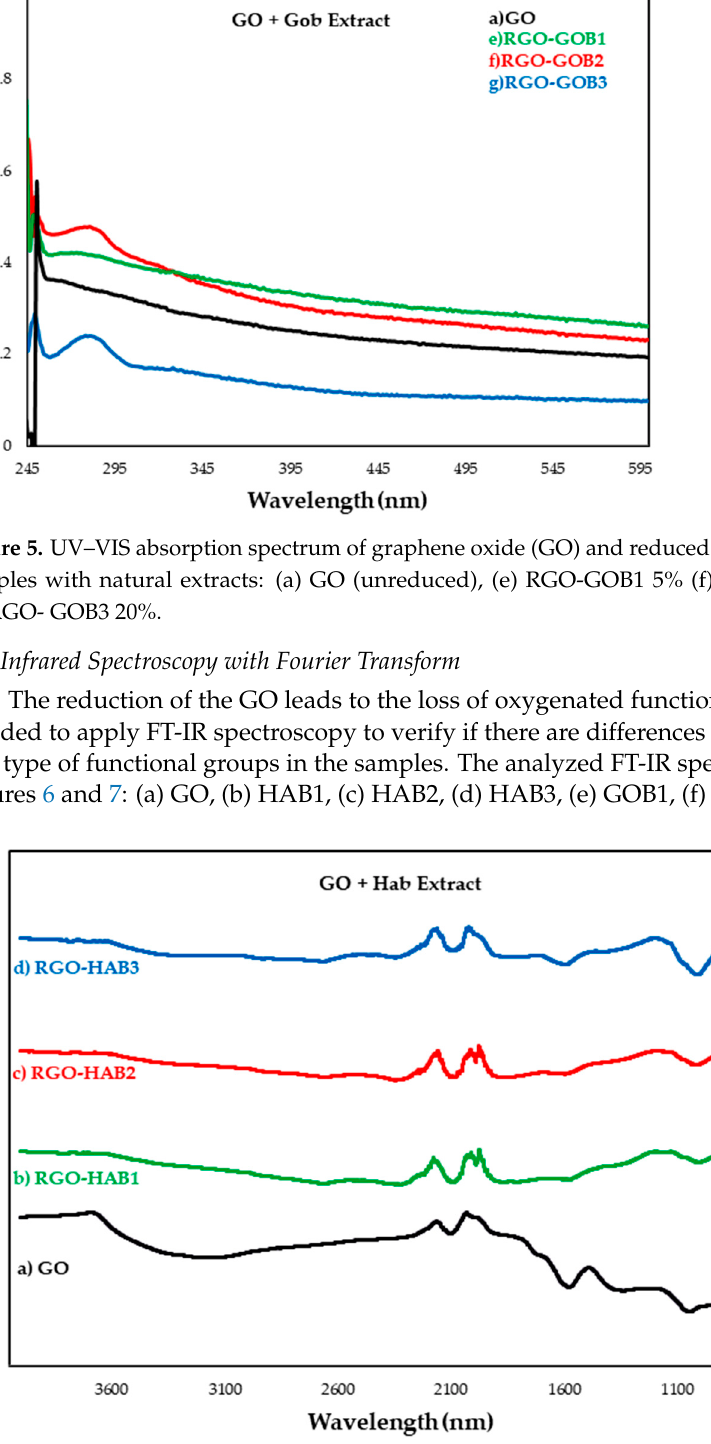
Figure 6. FT-IR transmittance spectrum of graphene oxide (GO) and reduced graphene oxide (RGO) samples with natural extracts. The analyzed samples are (a) GO (unreduced), (b) RGO-HAB1 5%, (c) RGO-HAB2 10% (d) RGO-HAB3 20%.